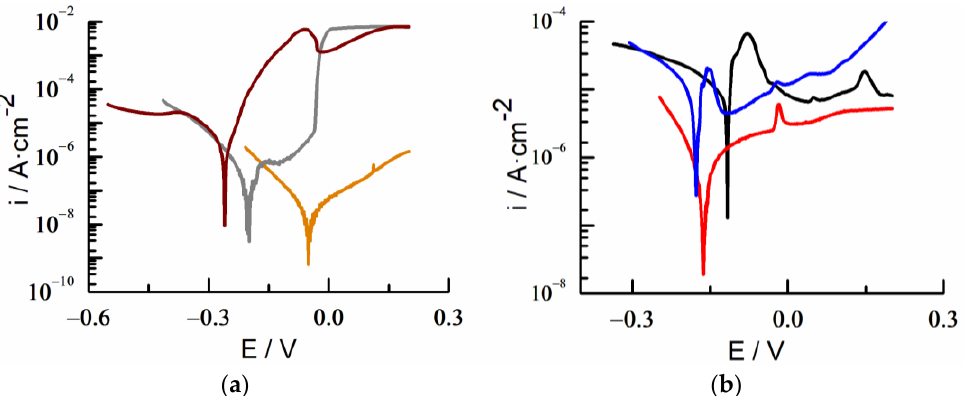
Figure 3. Polarization curves for wire surfaces of ( a ) pure copper (wine), silver (grey), and gold (orange), and ( b ) 18K (black), 14K (red), and 9K (blue) gold alloys in NaCl 3.5%.